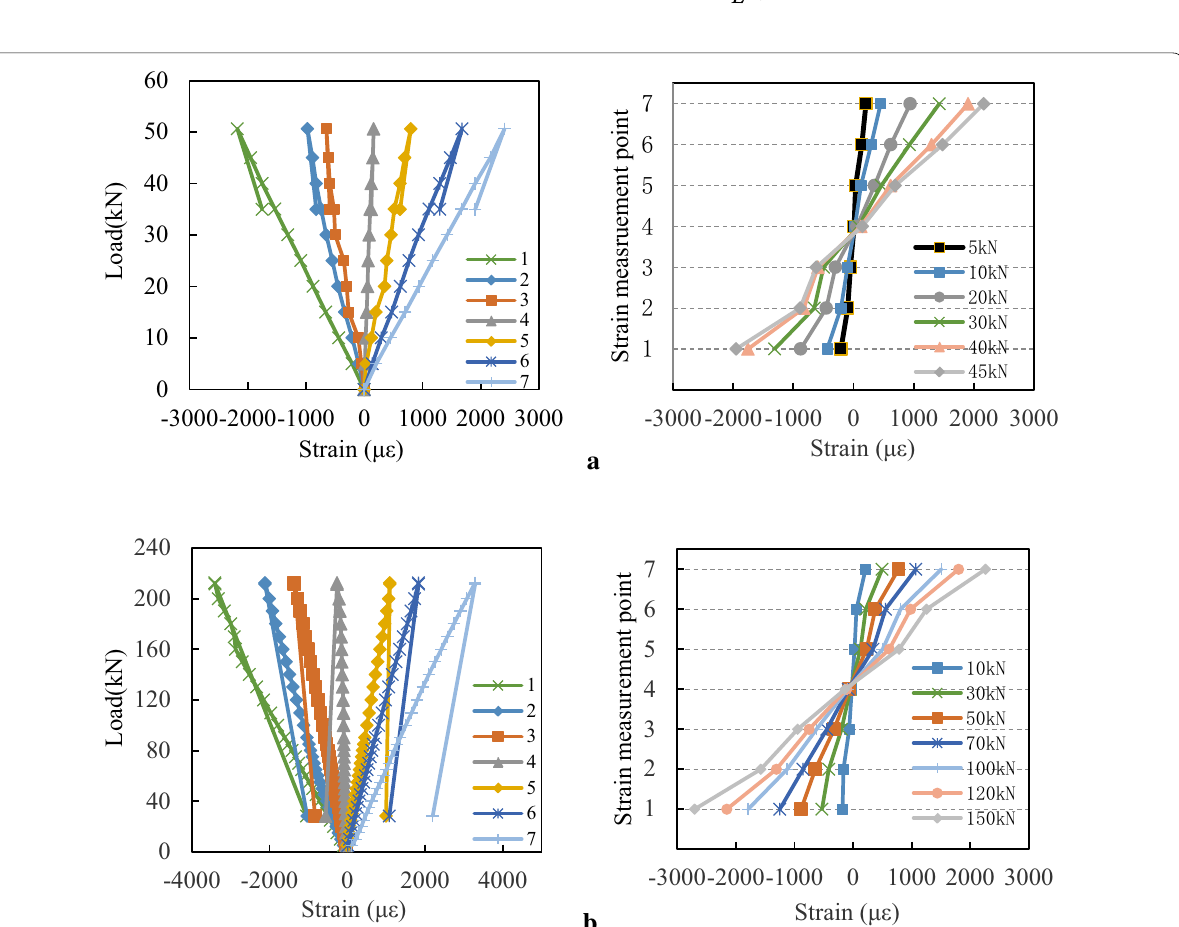
Fig. 6 Typical load–strain curves of the seven measurement points on the mid-span cross-section of W300 ( a ) and B600 ( b ) (left column); strain distributions of the 7 measurement points on the mid-span cross-section of W300 ( a ) and B600 ( b ) under different loads (right